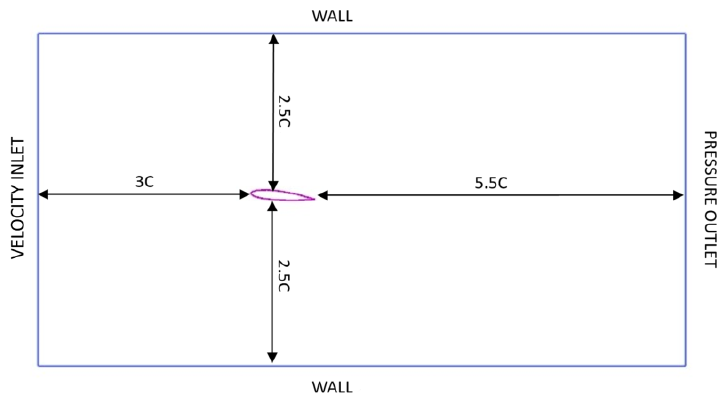
Figure 2. Monitor points.